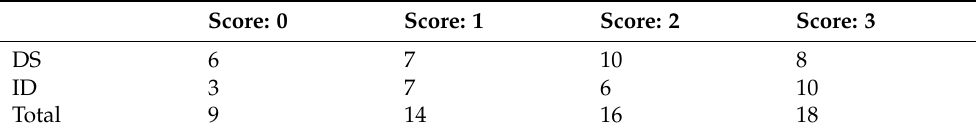
Table 5. Number of Participants in Each Possible Episodic Memory Score (highest: